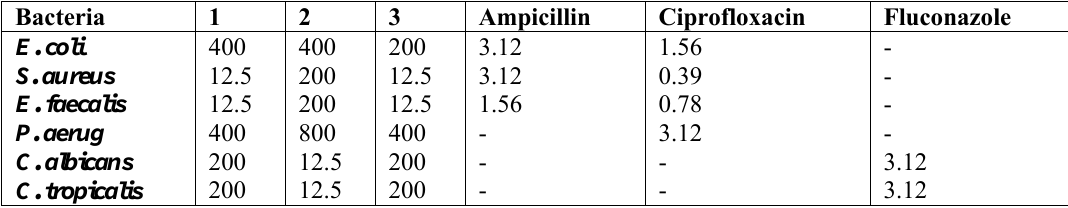
Table 1. Minimum inhibitory concentration ( μ g/mL) of silver NHC complexes tested against